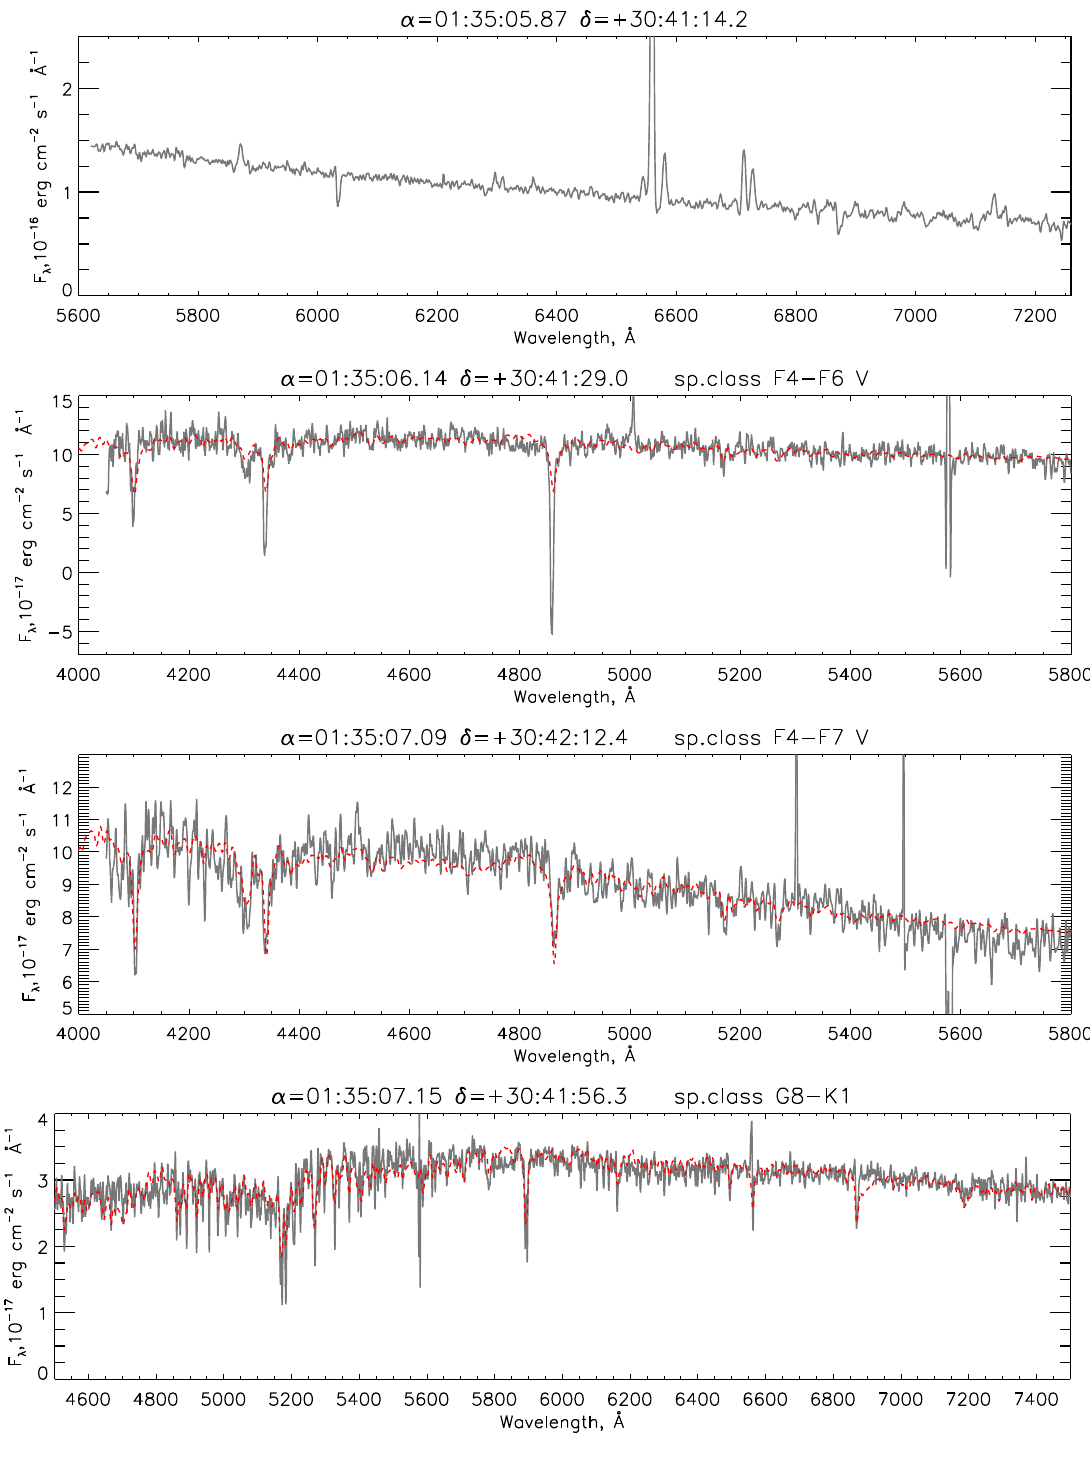
Figure A3. From the top panel downwards, spectra of the stars: J013505.87+304114.2, J013506.14+304129.0, J013507.09+304212.4 and J013507.15+304156.3. For comparison, the reddened spectra of HD126141 (F5V), HD101606 (F4V) and HD75532 (G8V) are shown by red dashed